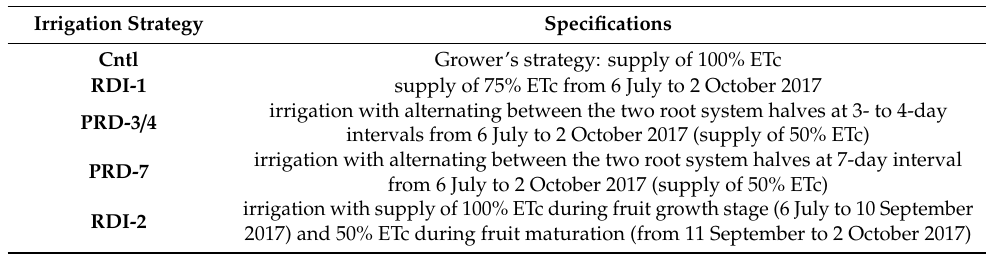
Table 1. Irrigation strategies